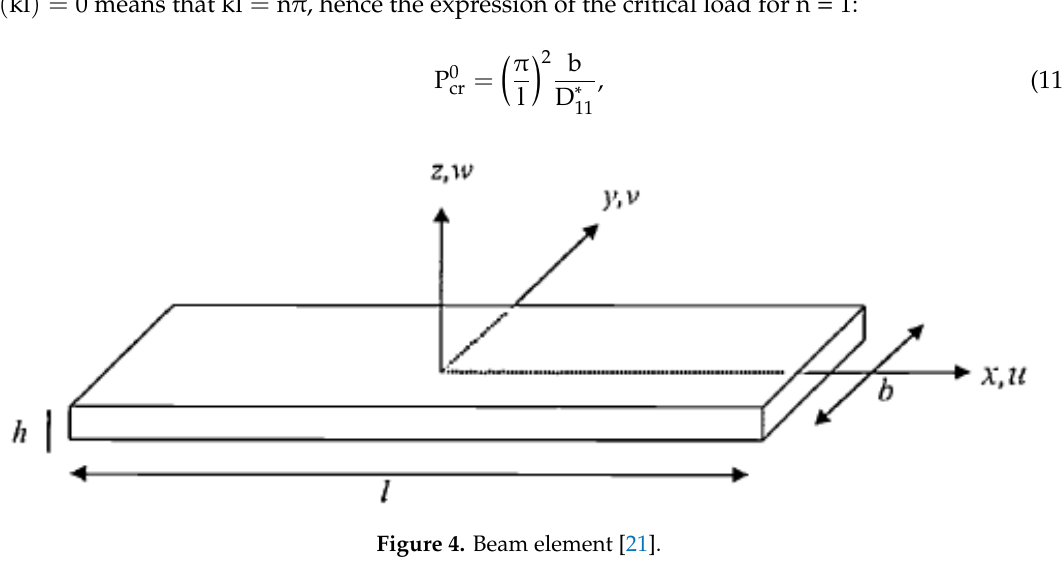
Figure 4. Beam element [ 21 ].